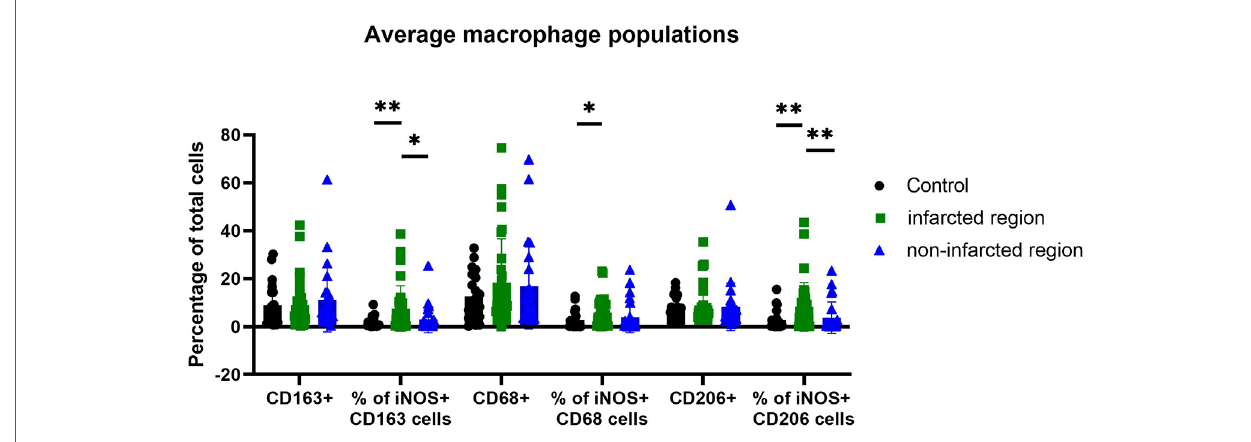
FIGURE 3 Amount of iNOS-producing macrophage subpopulation in controls, non-infarcted and infarcted regions. Individual values were grouped and plotted. Statistical signi fi cance was indicated after normality and Mann-Whitney tests. Signi fi cance from left to right: % of iNOS+ CD163 cells ( p -value 0,0069 and 0,0116); % of iNOS+ CD68 cells ( p -value 0,0284) and % of iNOS+ CD206 cells ( p -value 0,0045 and 0,0060). In CD163+ and CD206+ cells iNOS expression is stronger increased than in CD68+